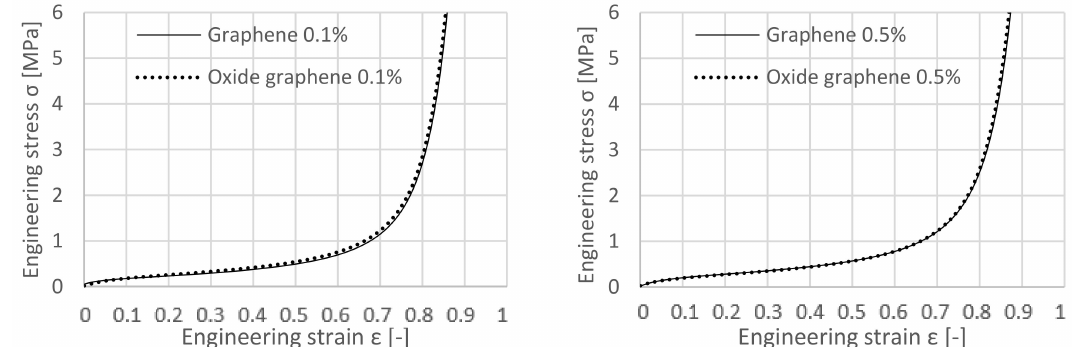
Figure 6. Comparison between samples with 0.1 wt.% GNP and 0.1 wt.% GO ( left ), Comparison between samples with 0.5 wt.% GNP and 0.5 wt.% GO respectively ( right ).